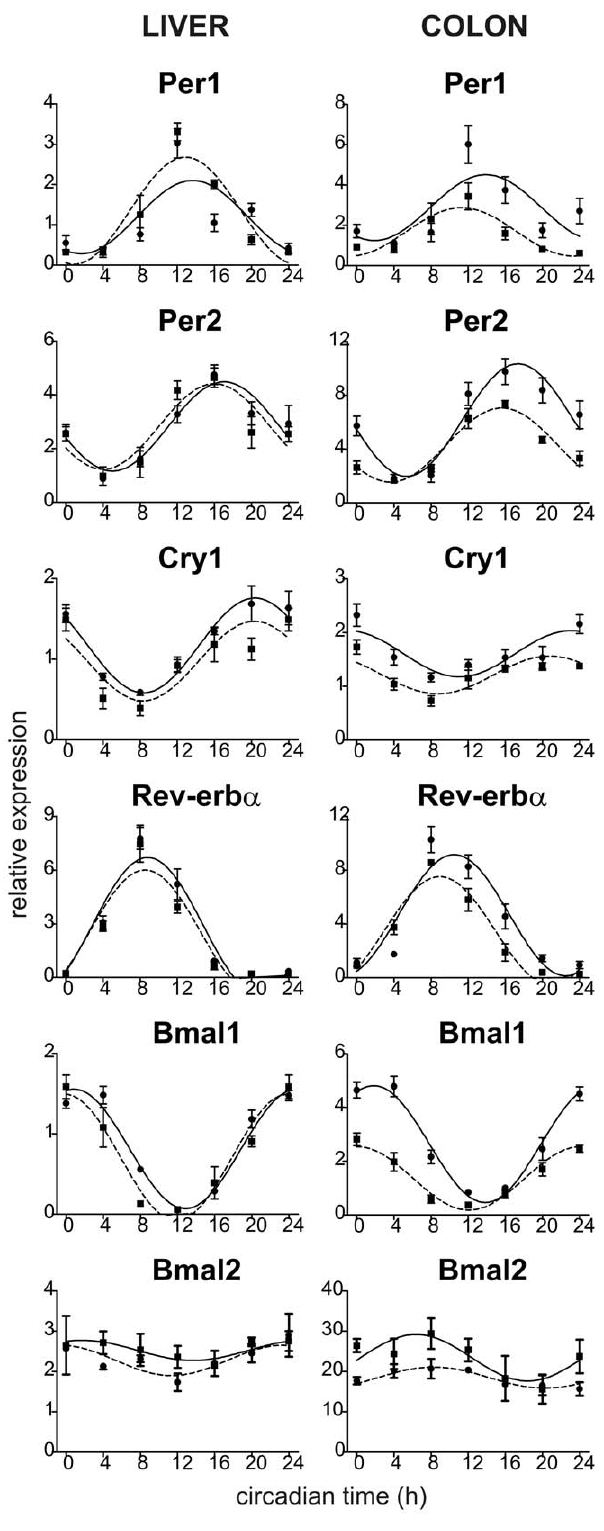
Figure 3. Clock gene expression profiles in the liver (left) and colon (right) of Wistar rats (full line) and SHR (dashed line). The rats were maintained and sampled as described in Fig. 2. Daily profiles of relative expression of Per1 , Per2 , Cry1 , Rev-erb a , Bmal1 and Bmal2 mRNA levels were determined by RT-PCR. Time is expressed as circadian time (h) with CT0 corresponding to lights-on on the previous LD cycle